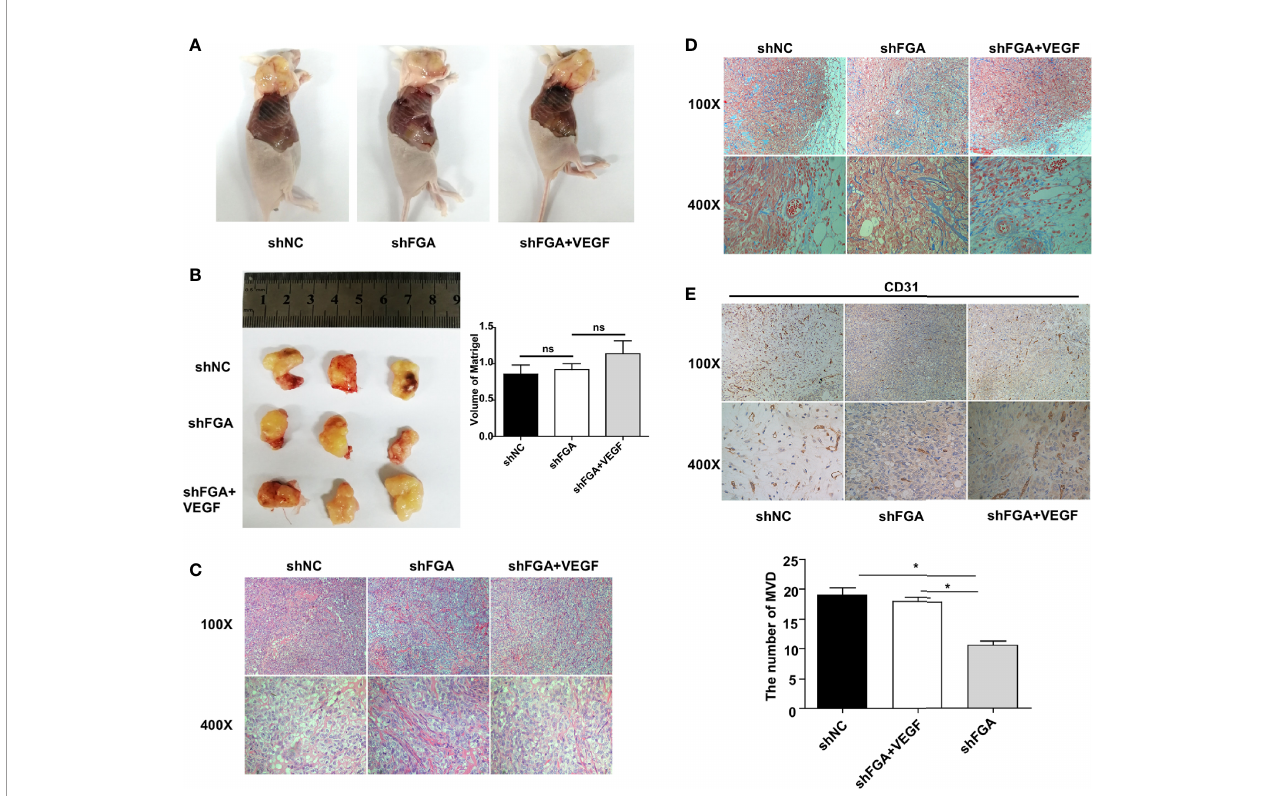
FIGURE 4 | Effect of conditioned medium (CM) of hEM15A with FGA knockdown on the angiogenesis in vivo . (A) The representative anatomical images of female BALB/c nude mice after subcutaneous injection with HUEVCs treated with CM of hEM15A shNC cells (shNC group), CM of hEM15A shFGA cells (shFGA group) and CM of hEM15A shFGA cells combined with VEGF (shFGA+VEGF group). (B) Representative images of matrigel plugs at day14 after resection (left) and quantitative analysis of volume of plugs among three groups (right). (C, D) Representative images of matrigel plugs sections using HE staining (C) and Masson staining (D) showing tissue morphology, cells in fi ltration and angiogenesis in three groups. (E) Immunohistochemical images of CD31-positive endothelial cells in matrigel plugs sections (upper) and quantitative analysis (bottom) of the number of MVD in shNC group, shFGA group and shFGA+VEGF group. * P <0.05, ns, not signi fi cant, P ≥